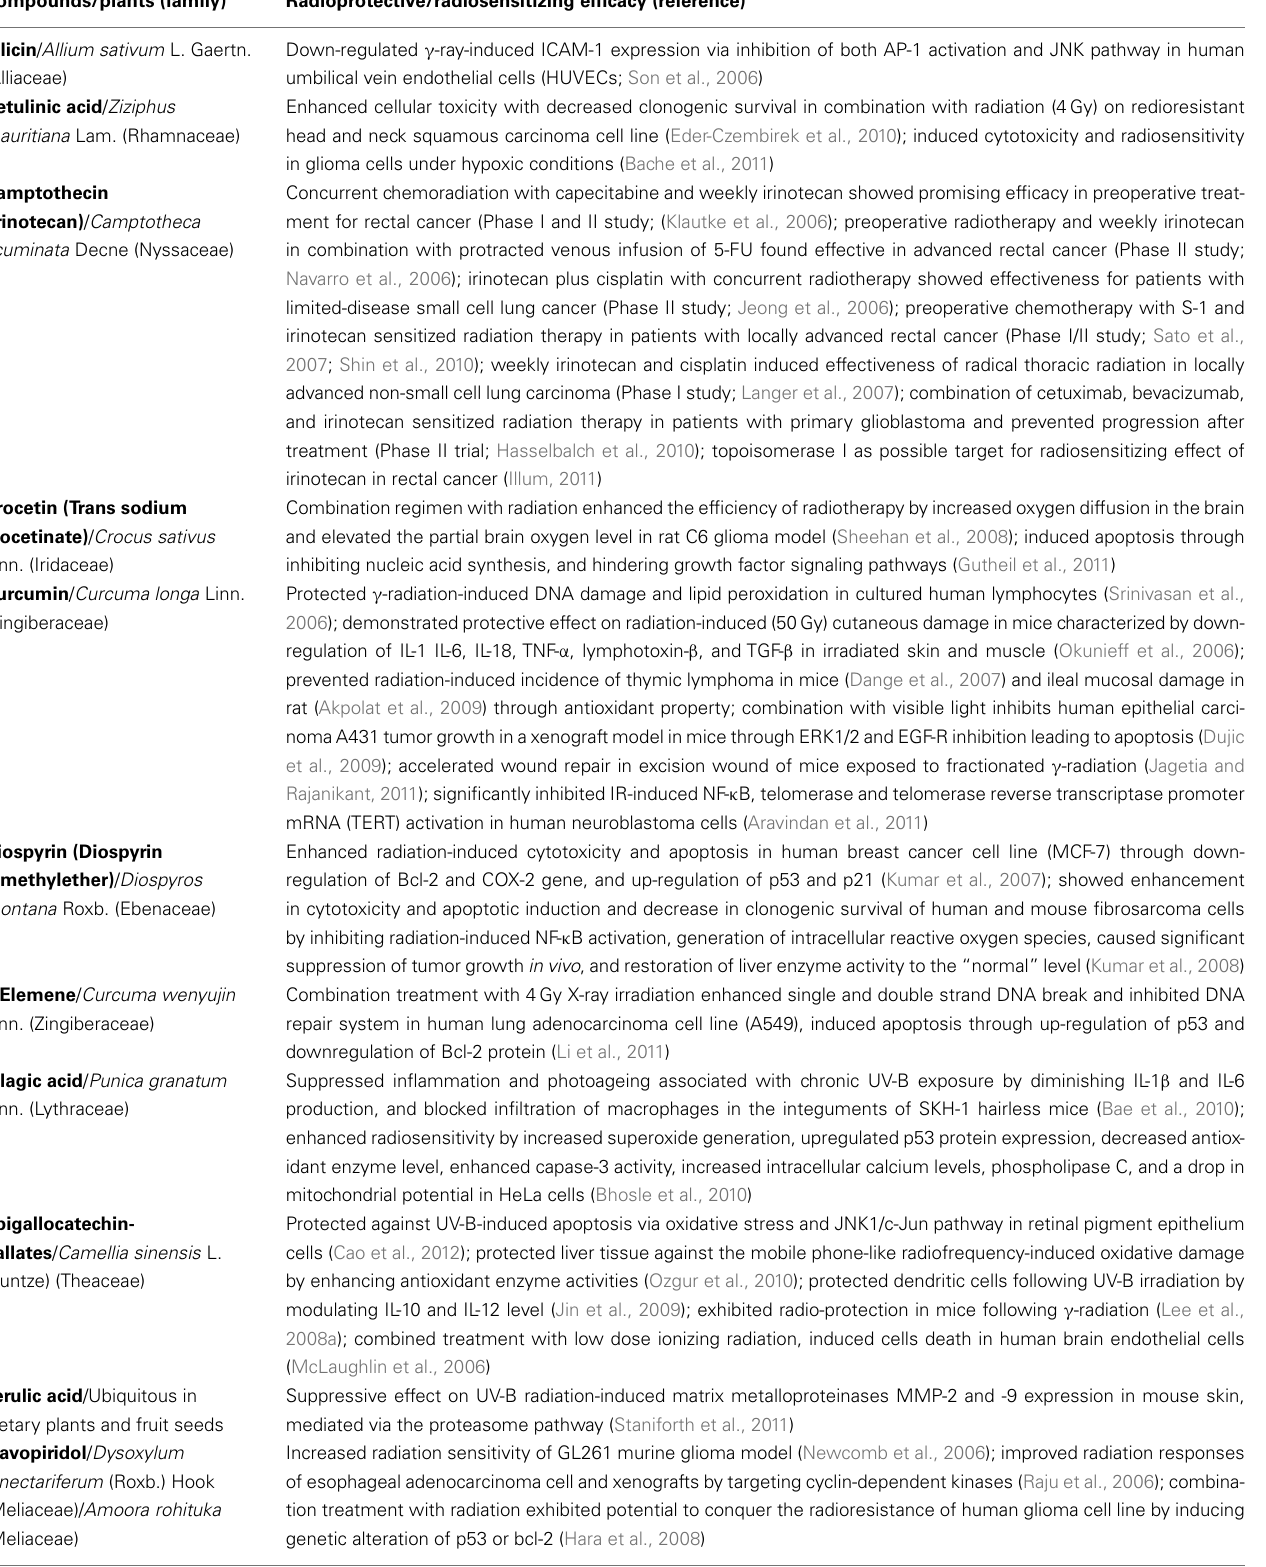
Table 2 | Phytochemicals with prospective radioprotective/radiosensitizing efficacy: reports from last 5years study. Compounds/plants (family) Radioprotective/radiosensitizing efficacy (reference) Allicin / Allium sativum L.